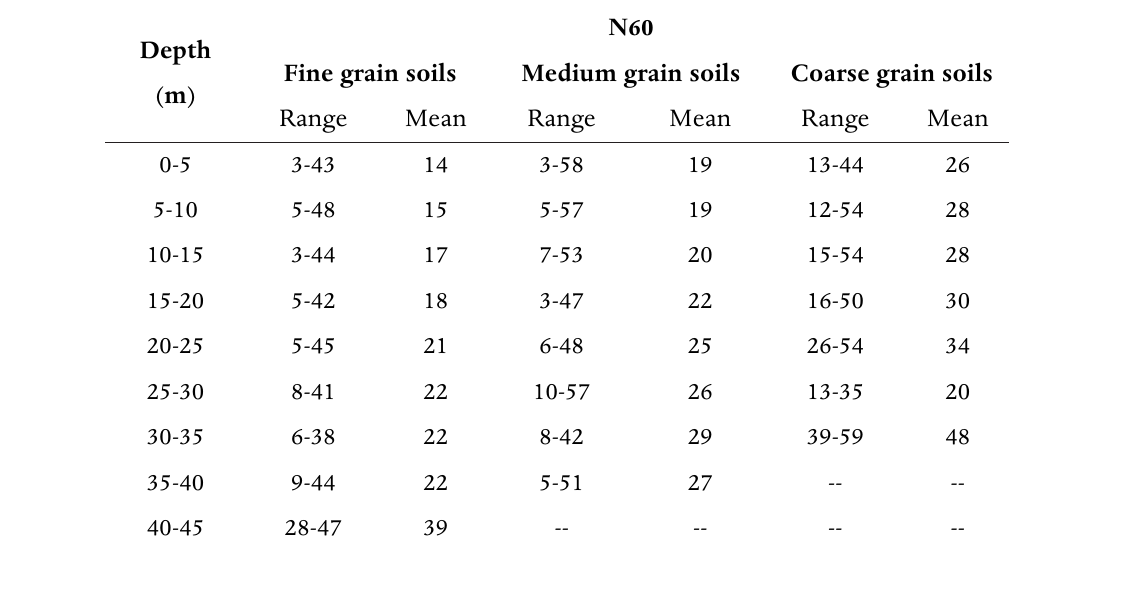
Table 1. Variations of the N-SPT with depth in the study